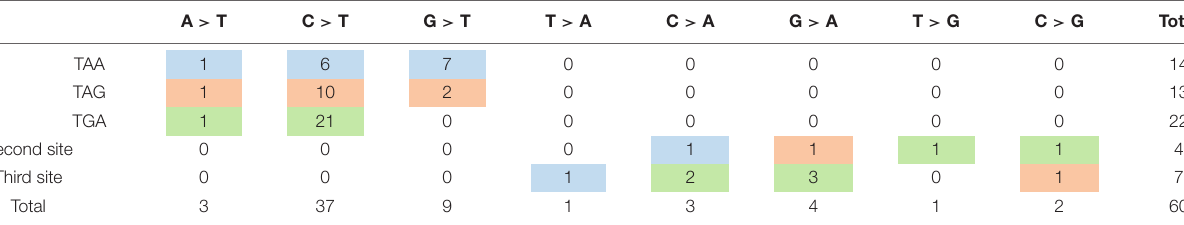
TABLE 2 | Base substitutions observed in nonsense mutations.